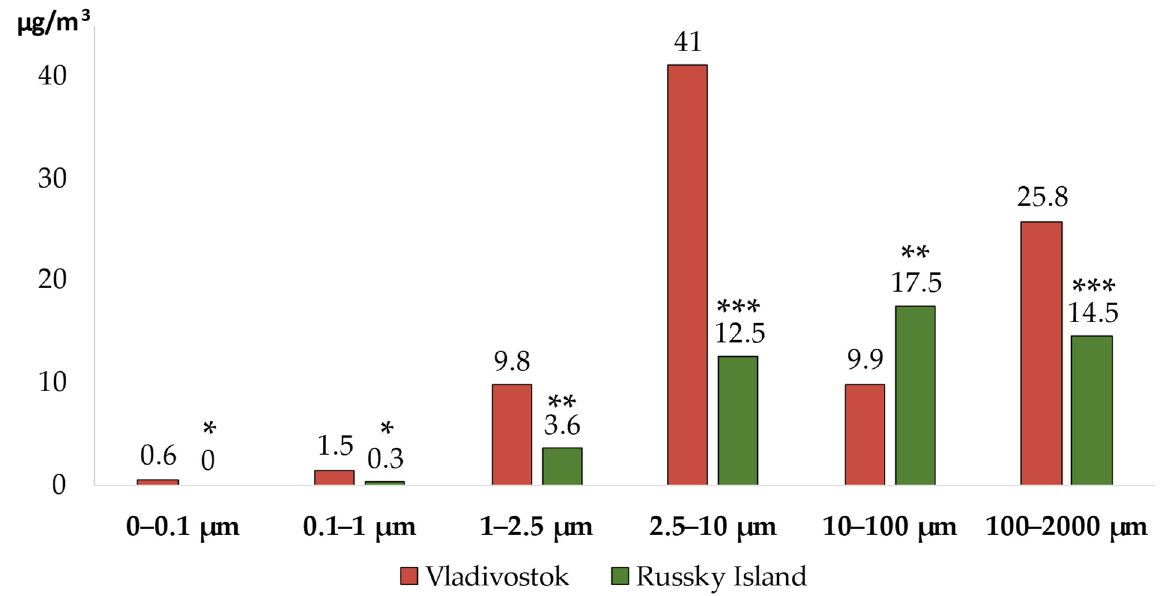
Figure 1. The level of SPM pollution of the air in the atmospheric surface layer in the districts of Vladivostok with varying degrees of man-made load. Statistical significance relative to Vladivostok: *— p < 0.05; ** —p < 0.01; ***— p < 0.001.